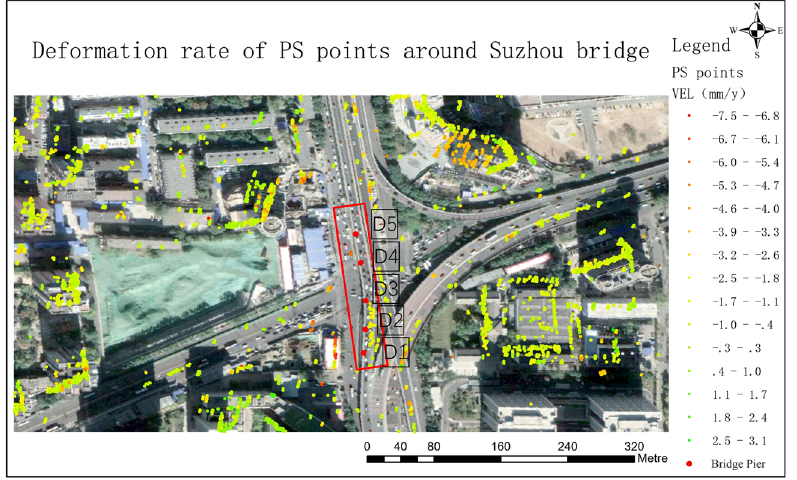
Figure 2. Deformation rate of PS points in the line-of-sight direction around Suzhou Bridge.